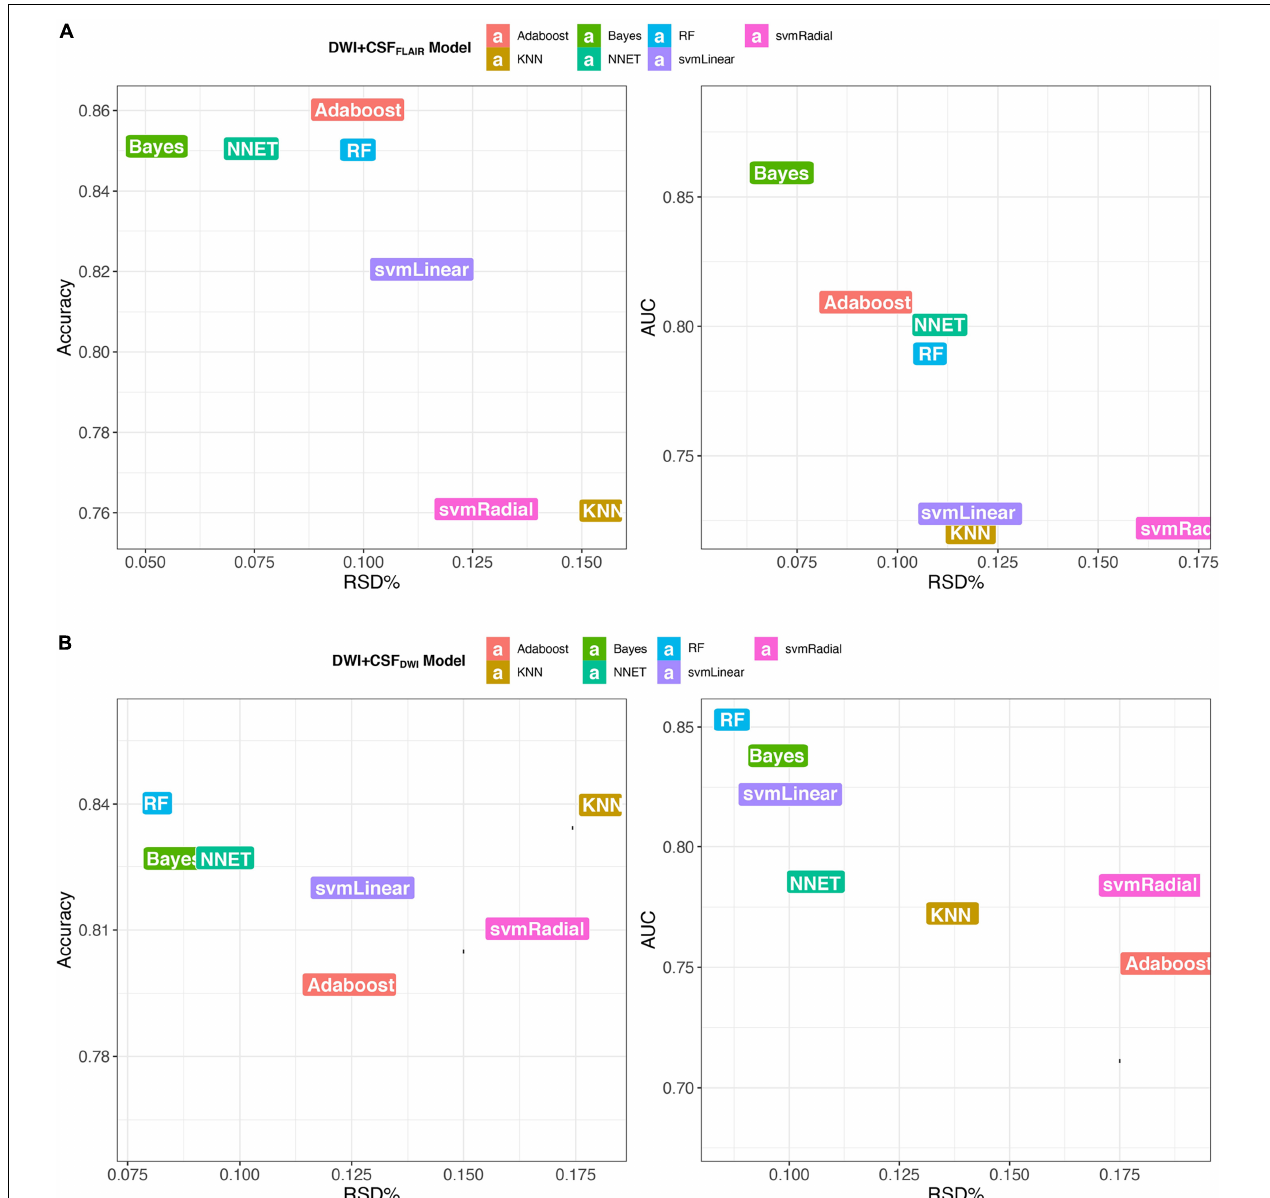
FIGURE 4 | Accuracy and AUC vs. RSD of the 7 models, (A) models based on DWI + CSF FLAIR features; (B) models based on DWI + CSF DWI